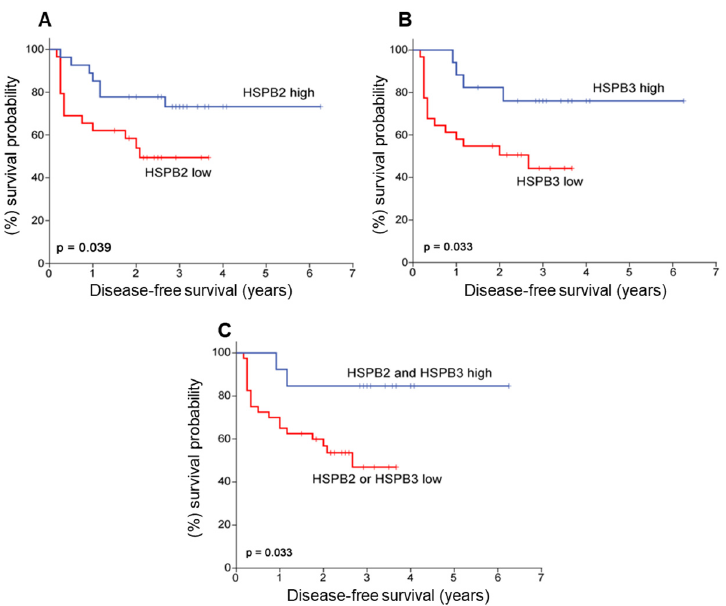
Figure 4. Kaplan–Meier survival curves for the disease-free survival (DFS) of NMIBC (TaT1) patients according to HSPB2 ( A ), HSPB3 ( B ) and both ( C ) mRNA expression levels. p -value was calculated using the log-rank test. Table 2. Cox regression analysis for the prediction of NMIBC (TaT1) patients’ risk for relapse (DFS) following treatment.